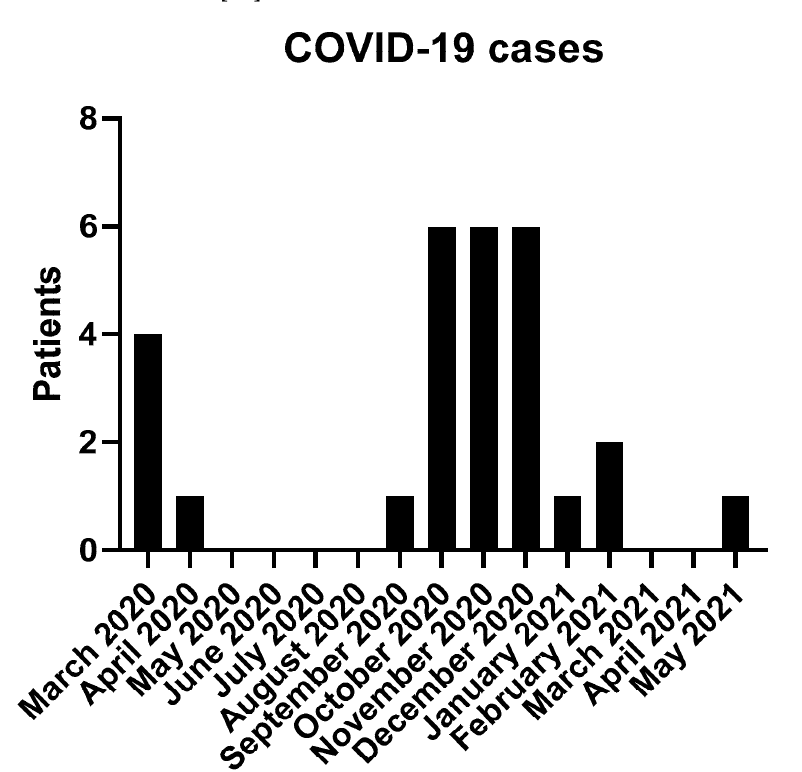
Figure 1. Showing the COVID-19 cases per month of our cohort.